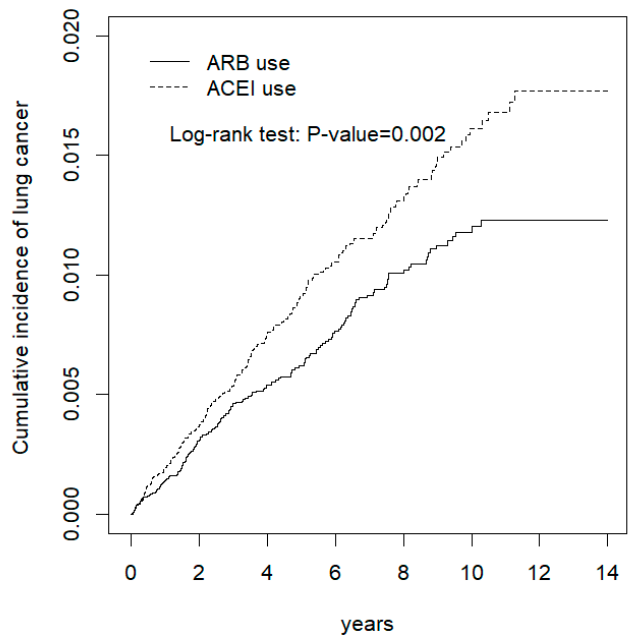
Figure 1. Cumulative incidence of lung cancer between ACEI and ARB users.